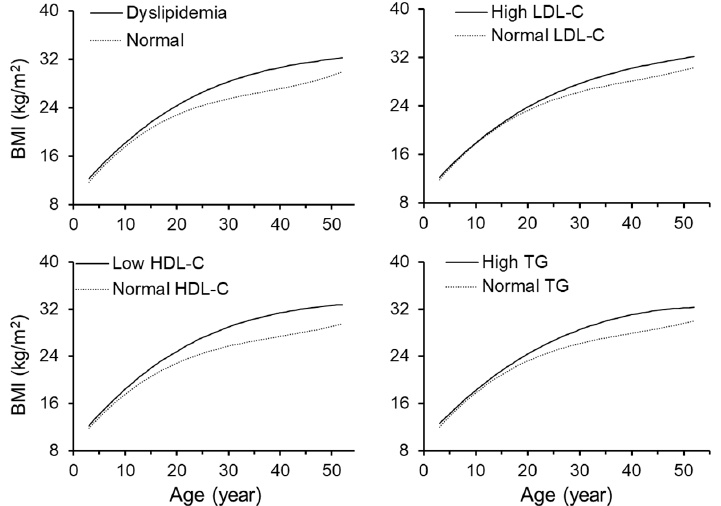
Figure 2. Growth curves of BMI in groups classified by dyslipidemia groups. BMI = body mass index; LDL-C = low-density lipoprotein cholesterol; HDL-C = high-density lipoprotein cholesterol; TG = triglycerides.